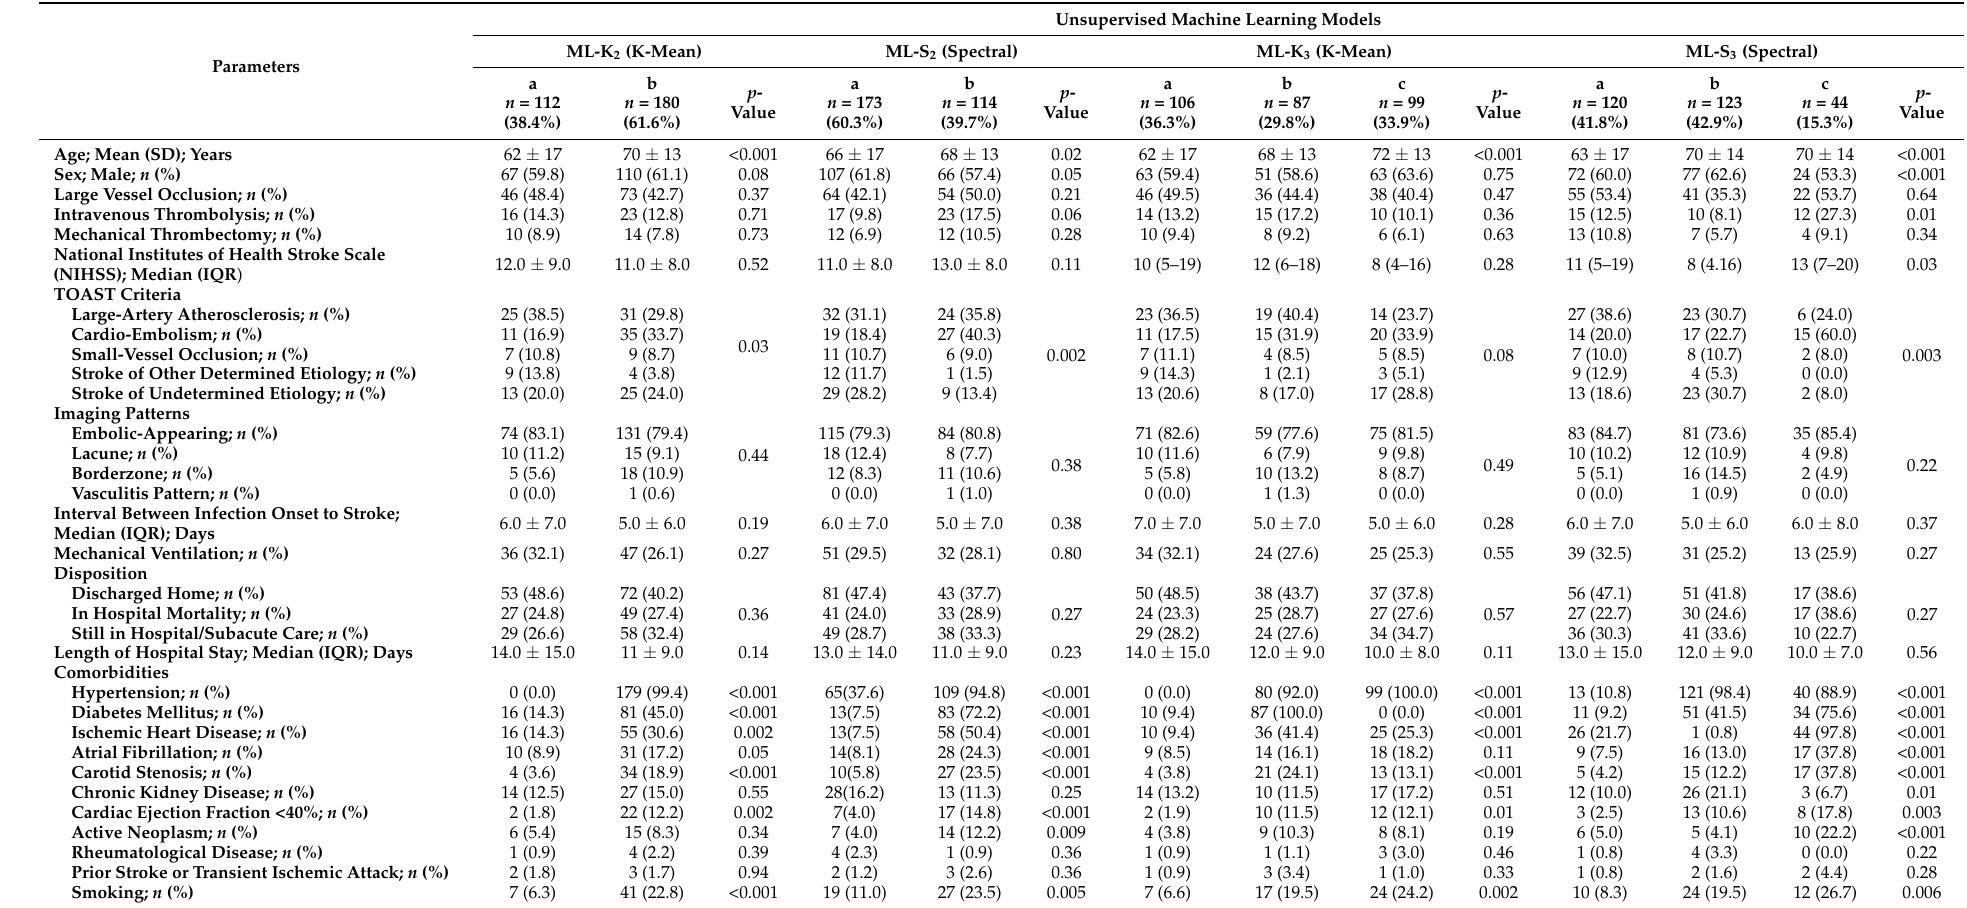
Table 2. Characteristics of the patients clustered with unsupervised machine learning